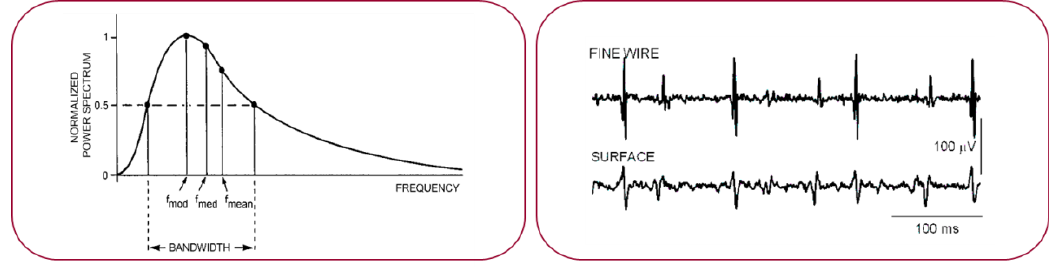
Figure 1. Sketch of a typical raw EMG signal recorded with fine wires or patch electrodes .